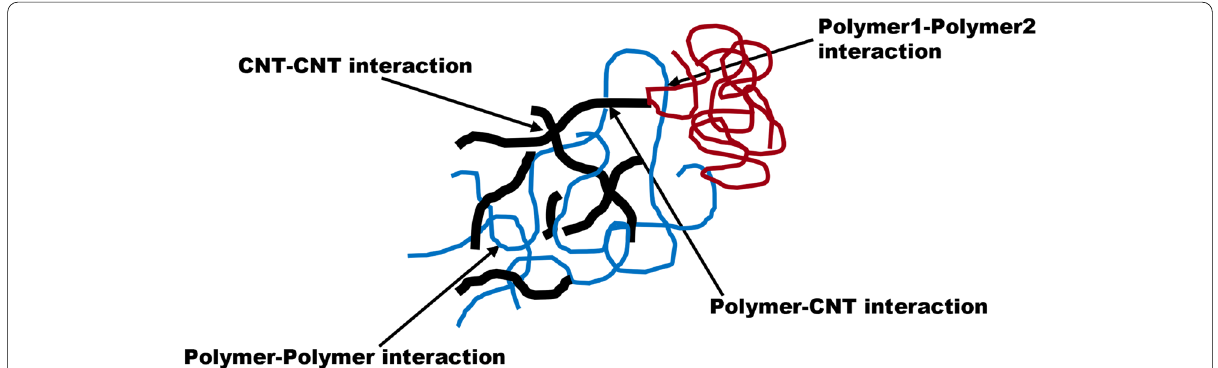
Fig. 1 Schematic illustration of polymer blend carbon nanotube interactions. Figure adapted from Ref